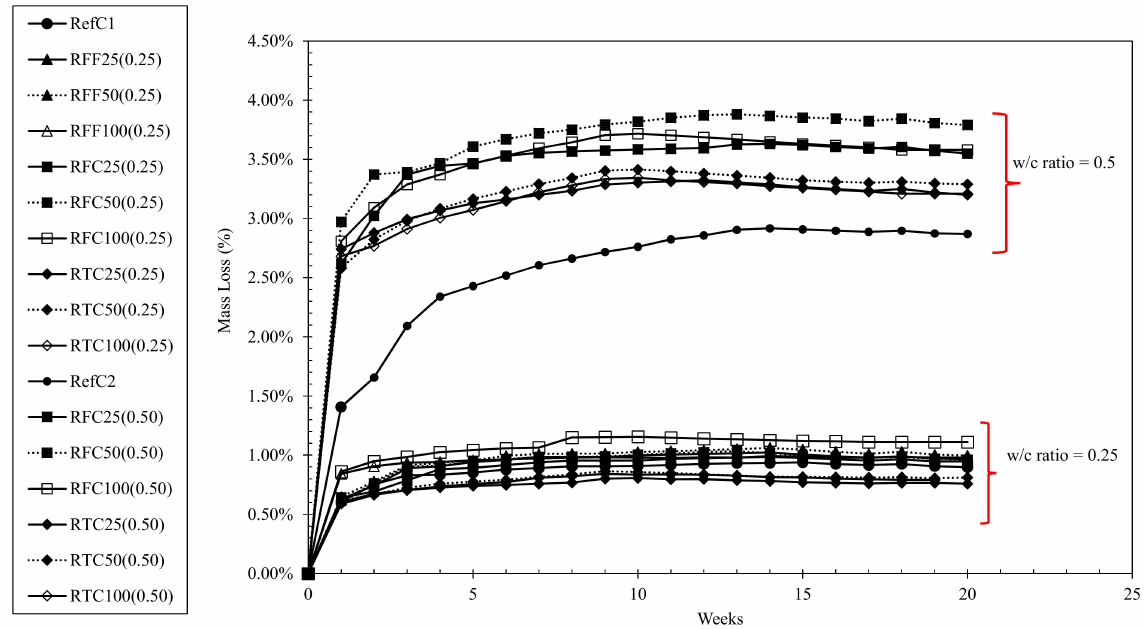
Figure 5. Mass loss measurements of concrete mixtures investigated for up to 20